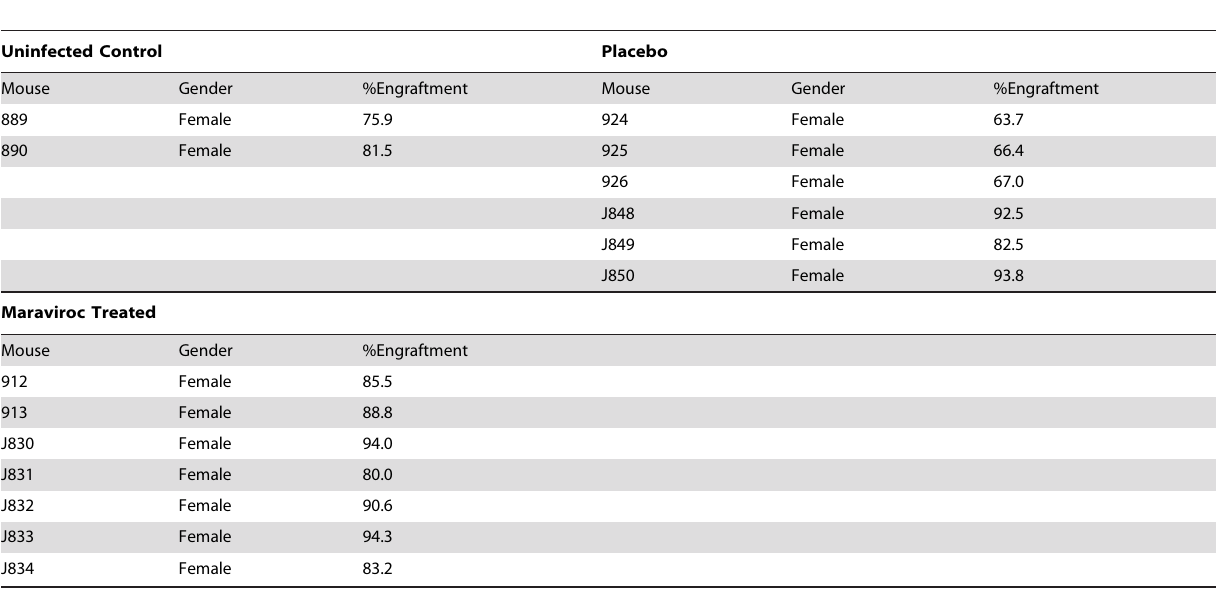
Table 1. Summary of human cell engraftment levels in humanized